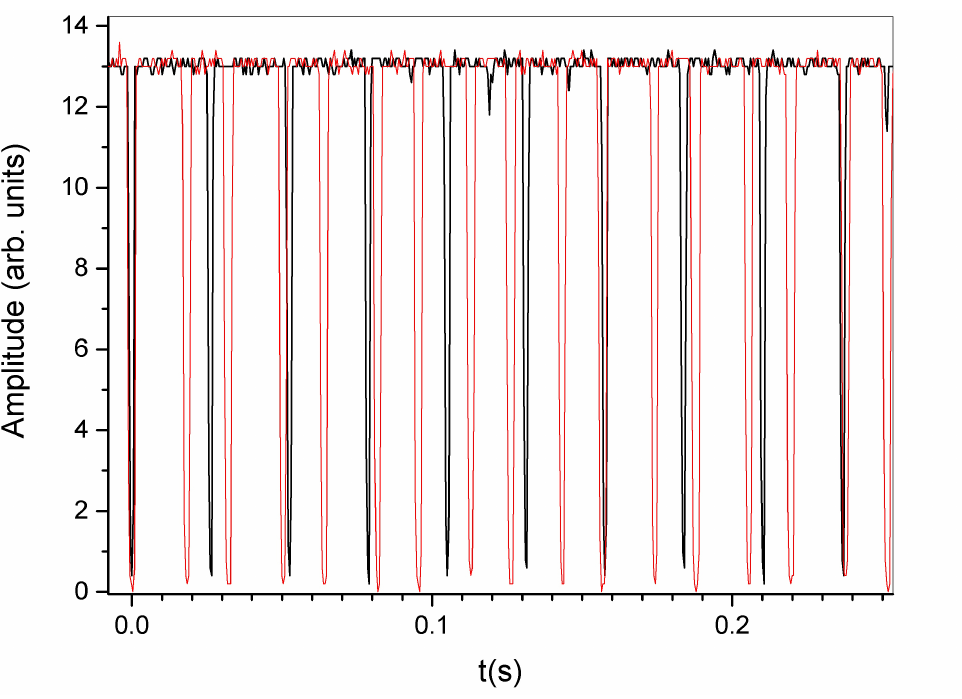
Figure 3. Oscillogram showing the rotational behaviour of the PMP film before (black line) and after (red line) external